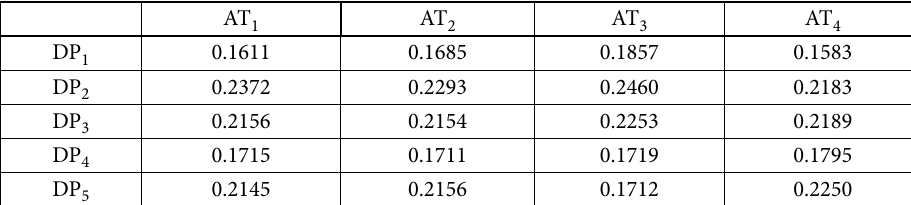
Table 9. The prospect weight of each alternative based on e 2 AT 1 AT 2 AT 3 AT